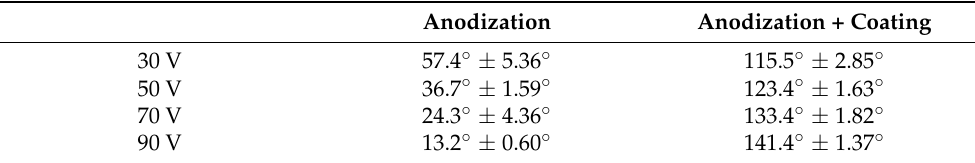
Table 4. Contact angle between anodized stainless steel and FDTS coated stainless steel 316L accord- ing to the applied